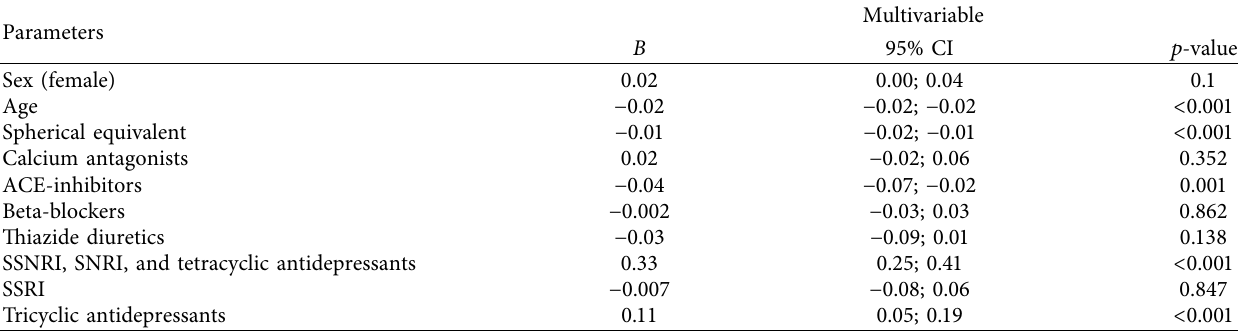
Table 2: Association analysis of antihypertensive drug intake and pupil size. Data from the population-based Gutenberg Health Study in 2012–17 ( n � 16, 266 eyes).